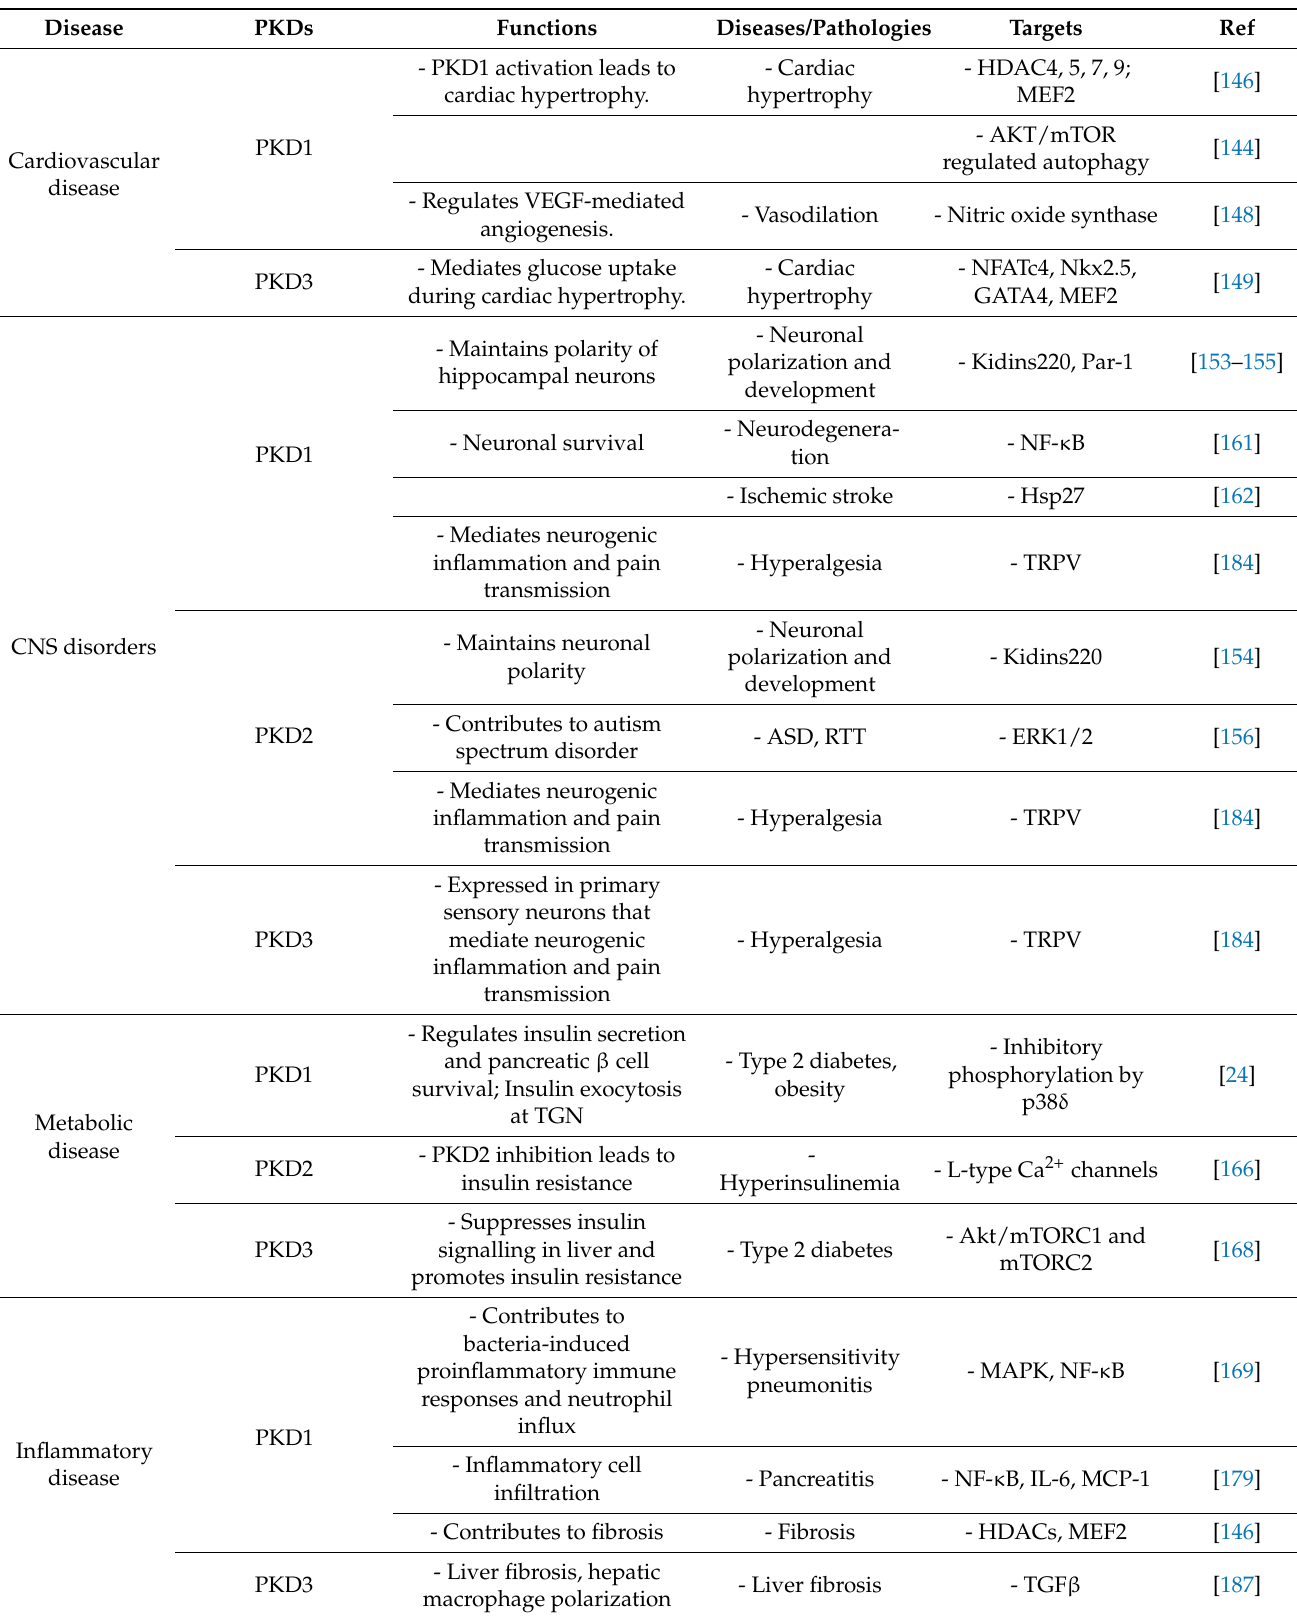
Table 2. Versatile roles of PKD in human diseases besides